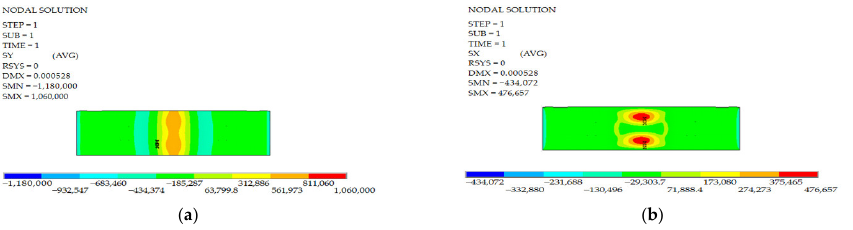
Figure 15. Stress diagram of the mid-span cross section of the bottom surface of the base plate. ( a ) Longitudinal stress cloud diagram; ( b ) longitudinal stress data graph; ( c ) lateral stress cloud dia- gram; ( d ) lateral stress data graph.